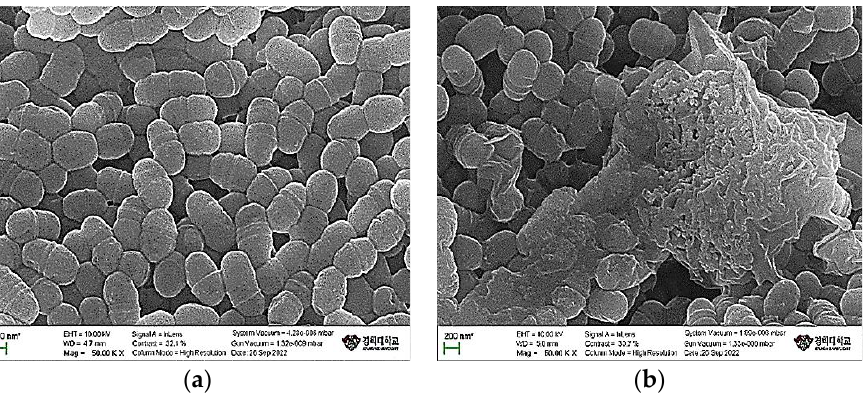
Figure 2. Scanning electron micrographs of untreated S. mutans and after 24 h of treatment with SGE at a fixed magnification. S. mutans KACC 16833 ( a ). Treated with SGE ( b